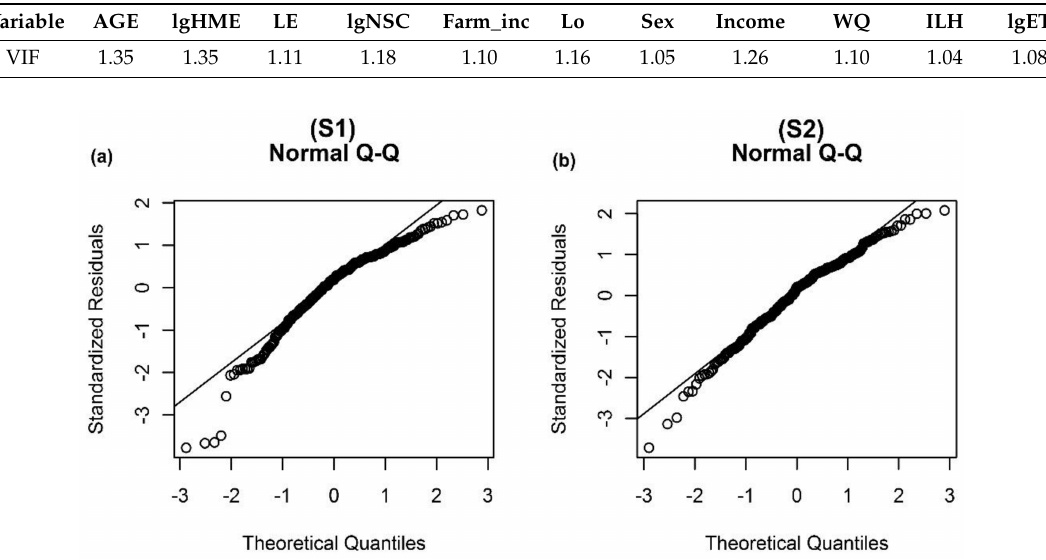
Figure 5. QQ plots of multivariate normality for ( a ) normality plots for S1; ( b ) normality plots for S2 (i.e the line showing normal distribution of